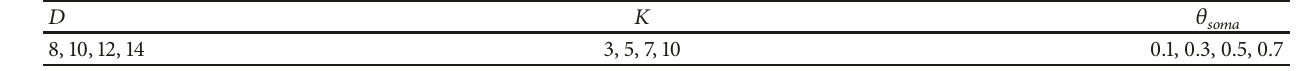
Table 1: Parameter levels in EPNN of the Qualitative Bankruptcy data set.